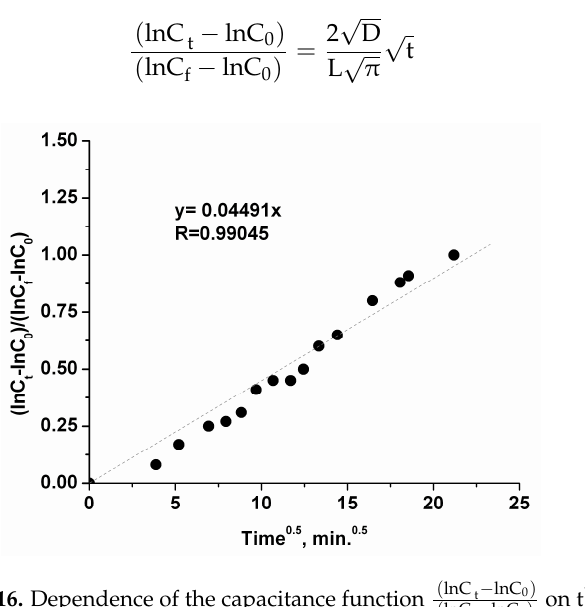
Figure 16. Dependence of the capacitance function